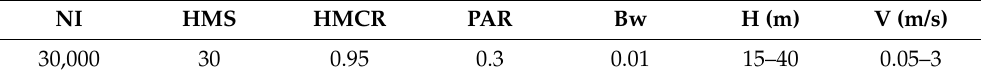
Table 4. Parameter settings for the HS algorithm and constraints on the objective function. NI HMS HMCR